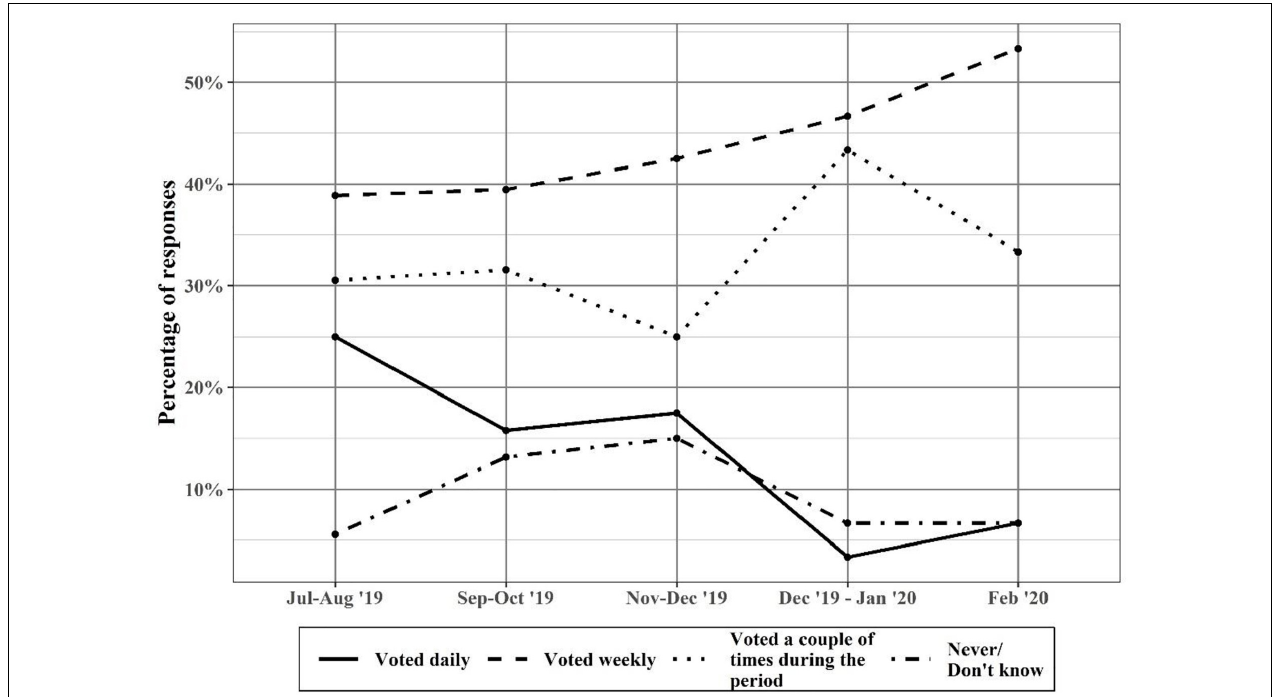
FIGURE 7 | Percentage of responses for the monthly and final questionnaires in case II related to the question “In the last 30 days, how often did you use TiAQ at your office?”.